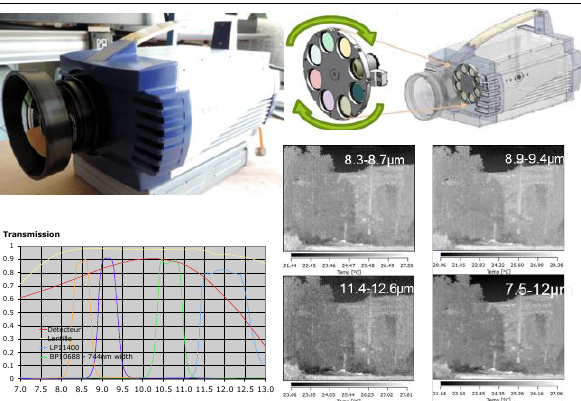
Figure 5. Infrared camera for airplane TELOPS MS-IR VLW (top left and right), filters transmission (bottom left), and ground images in the 4 spectral bands (bottom right)